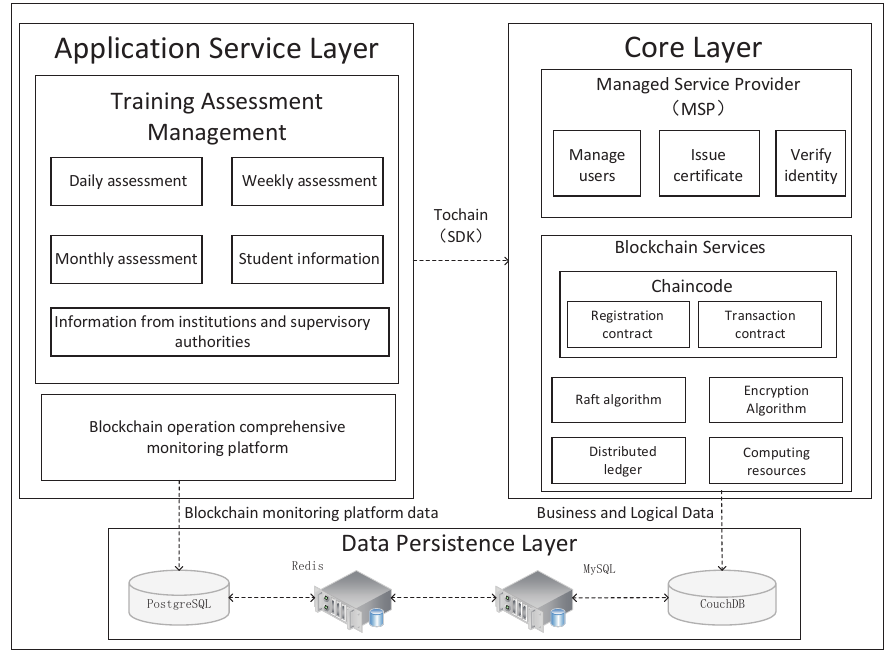
Figure 2. The platform